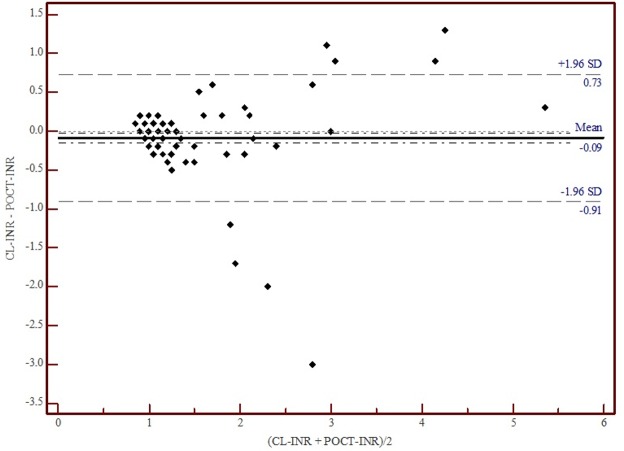
Bland-Altman plot showing the difference of the INR measurements.Fig 2 shows the difference of CL-INR and POCT-INR calculated for each patient and plotted against the mean value of both measurements (CL-INR + POCT-INR)/2). Main line shows the mean difference of the measurement values (0.09). The outer lines represent the limits of agreement within which 95% of differences between measurements by the two methods are expected to lie (-0.91 and +0.73).